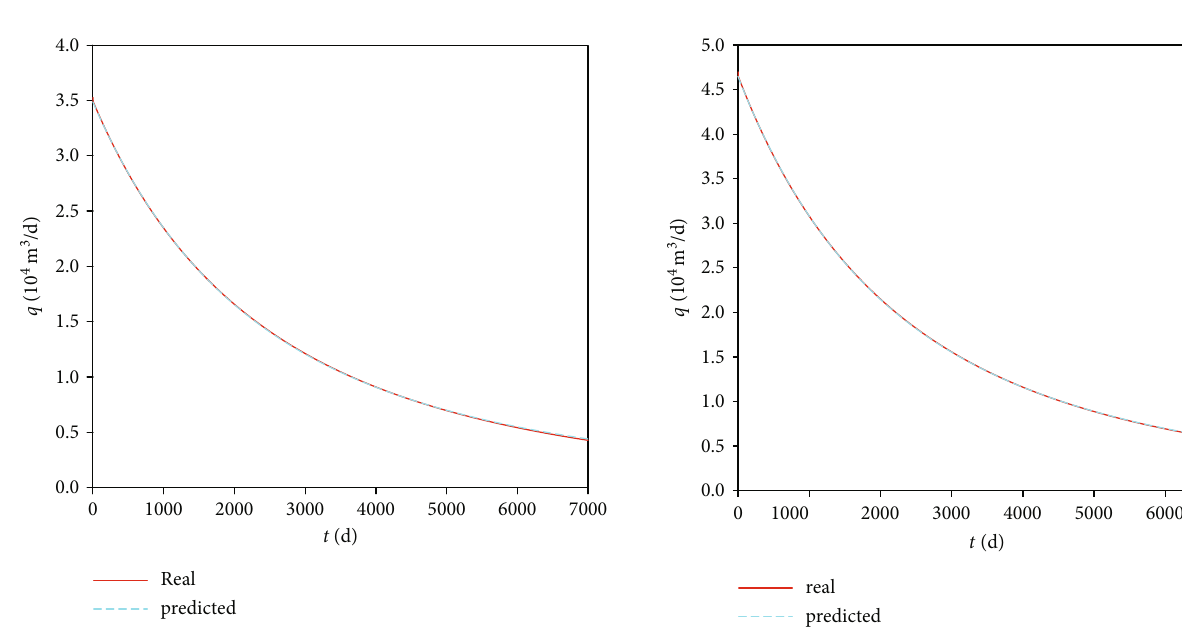
Figure 15: The real q pro fi le and the predicted pro fi le by the hyperbolic decline model for Case 1-4.